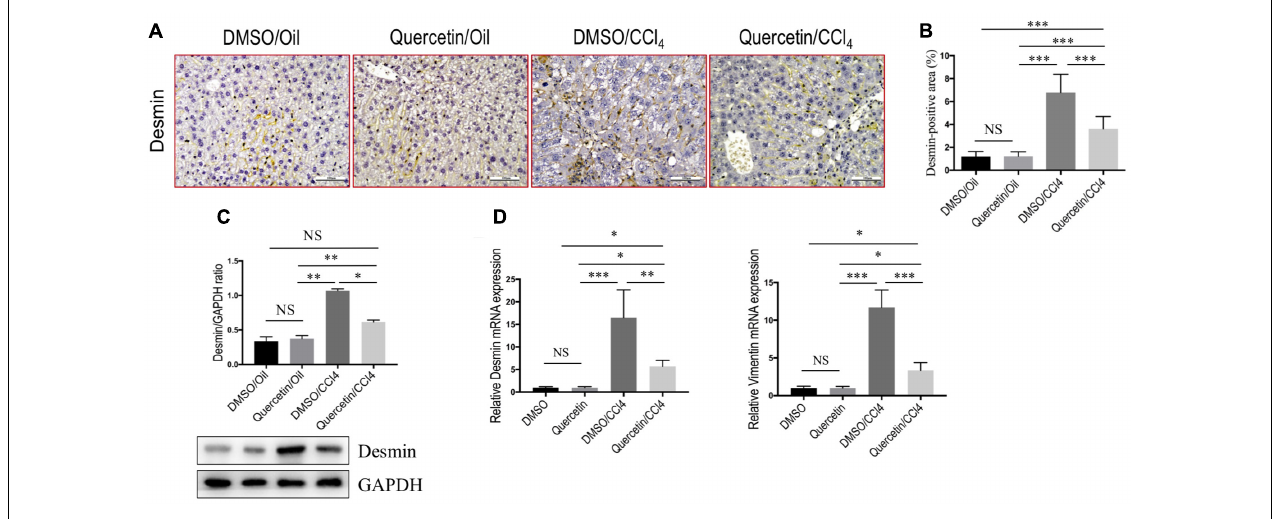
FIGURE 3 | Quercetin inhibited hepatic stellate cells (HSCs) activation in CCl 4 -treated mice. (A) Representative microscopy images of desmin staining (magnification: × 200) in the liver. Scale bar = 100 µ m. (B) Quantification of desmin-positive area by ImageJ software (NIH). Results mean of six fields and n = 5/group. (C) Western blotting analysis of desmin expression in lysed liver tissues, with results normalized relative to the expression of GAPDH ( n = 3). (D) Expression of desmin and vimentin mRNA was determined in the liver by quantitative RT-PCR ( n = 6). Results were normalized relative to GAPDH expression and expressed as mean ± SD fold change over normal control mice. ∗ P < 0.05; ∗∗ P < 0.01; ∗∗∗ P < 0.001; “NS” indicates not significant.